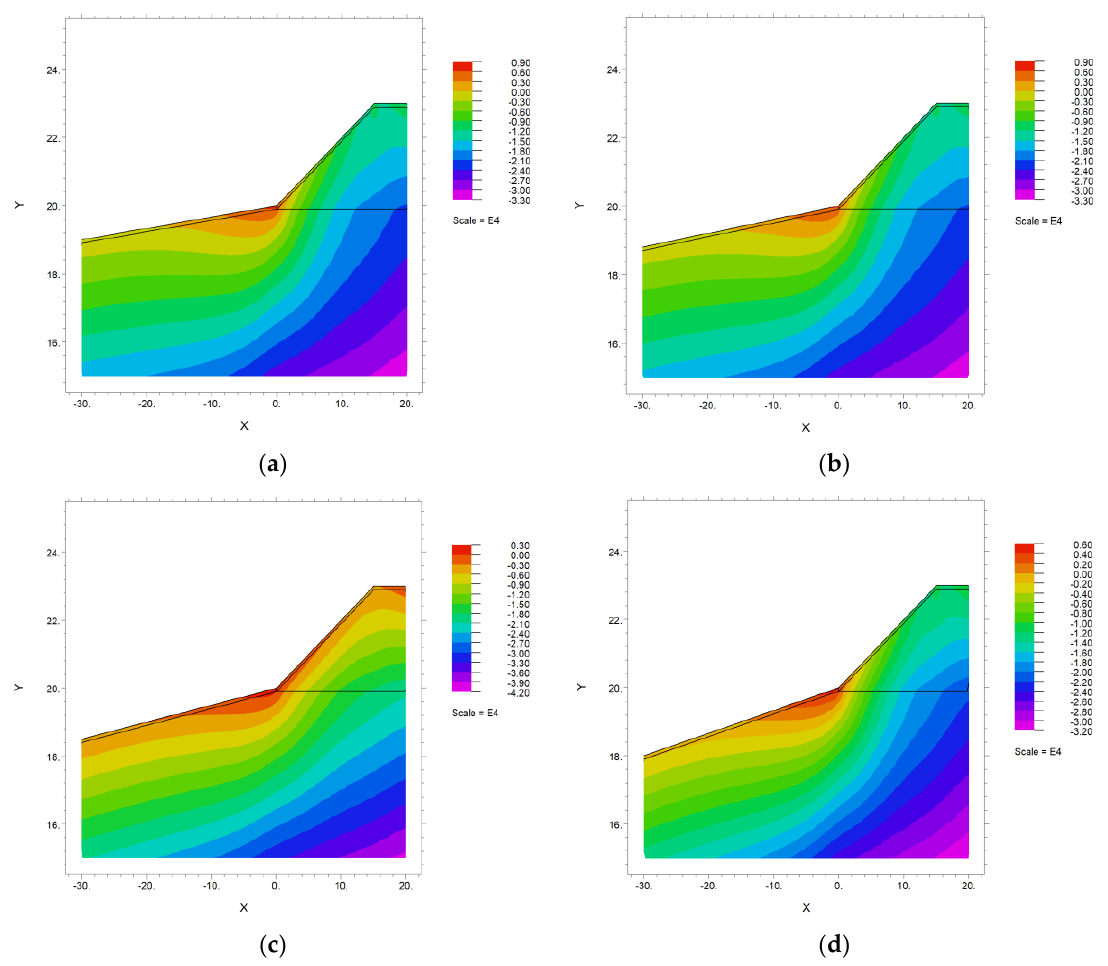
Figure 4. Horizontal stresses for the sand-type subsoil, for underwater slope inclinations of: ( a ) 1:30, ( b ) 1:25, ( c ) 1:20, ( d ) 1:15 (negative values indicate compressive stresses in Pa, and positive values — tensile stresses in Pa).